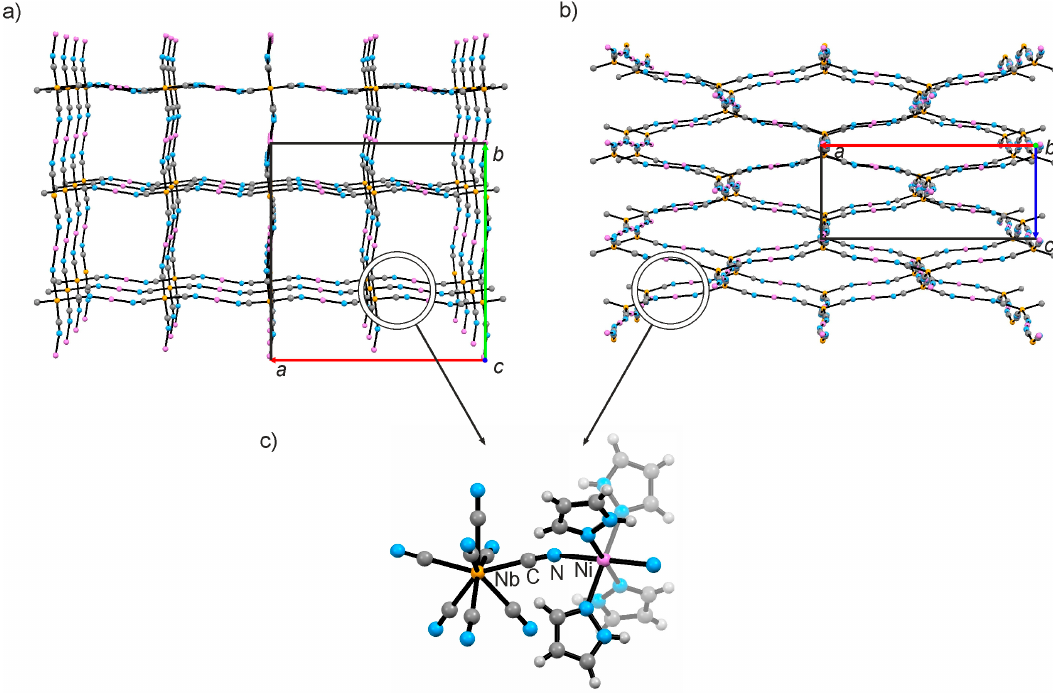
Figure 1. Structural diagrams presenting the cyanido-bridged framework of {[Ni II (pyrazole) 4 ] 2 [Nb IV (CN) 8 ]·4H 2 O} n down crystallographic axis z ( a ) and axis x ( b ). H 2 O, pyrazole and non-bridging CN − are omitted for clarity. ( c ) The local geometry of the Nb IV -CN-Ni II structural motif. Table 1. Single-crystal X-ray diffraction (scXRD) unit-cell parameters for Ni 2 Nb at room temperature and high pressure.